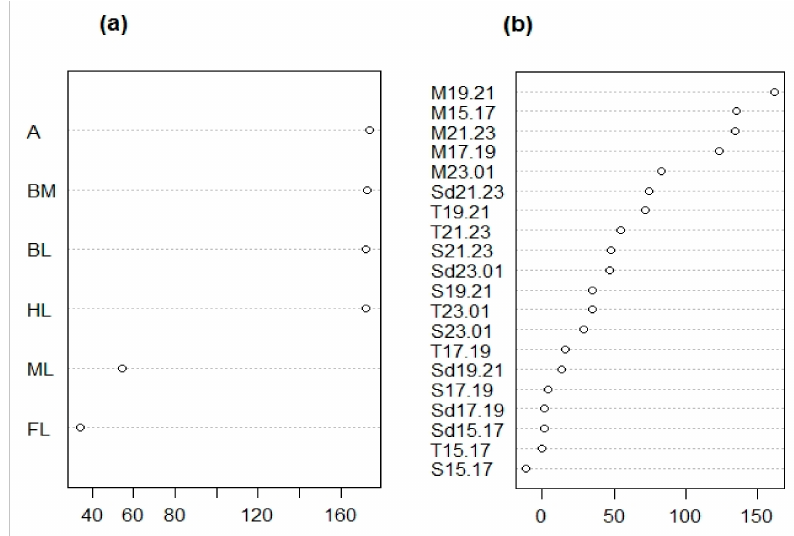
Figure 3. Ranking of mean decrease in accuracy (MDA) scores after a random forest analysis comparing morphological ( a ) and chemical ( b ) traits of males vs. female Clitarchus hookeri . (a) A statistical classification indicates the main morphological features distinguishing males and female Clitarchus hookeri are the antennae length ratio (A), body mass ratio (BM), total body length (BL), and hind leg length ratio (HL). (b) Chemical traits distinguishing males and females are monoterpenes (M) emitted between 15:00–23:00 in two hour intervals, i.e., 15:00–17:00 (15.17), 17:00–19:00 (17.19), 19:00–21:00 (19.21), and 21:00–23:00 (21.23). For details on the codes, see Table